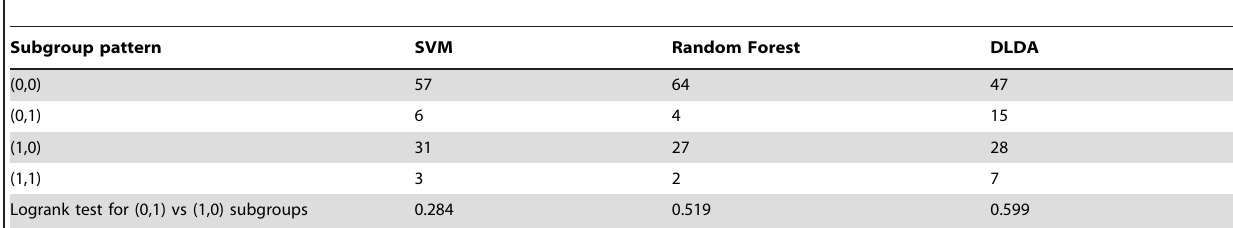
Table 3. Subgroup classification for the 97 breast cancer patients (46 from patients who developed distant metastases within 5 years and 51 from patients who continued to be disease-free after a period of at least 5 years) using the SVM, RF, and DLDA composite